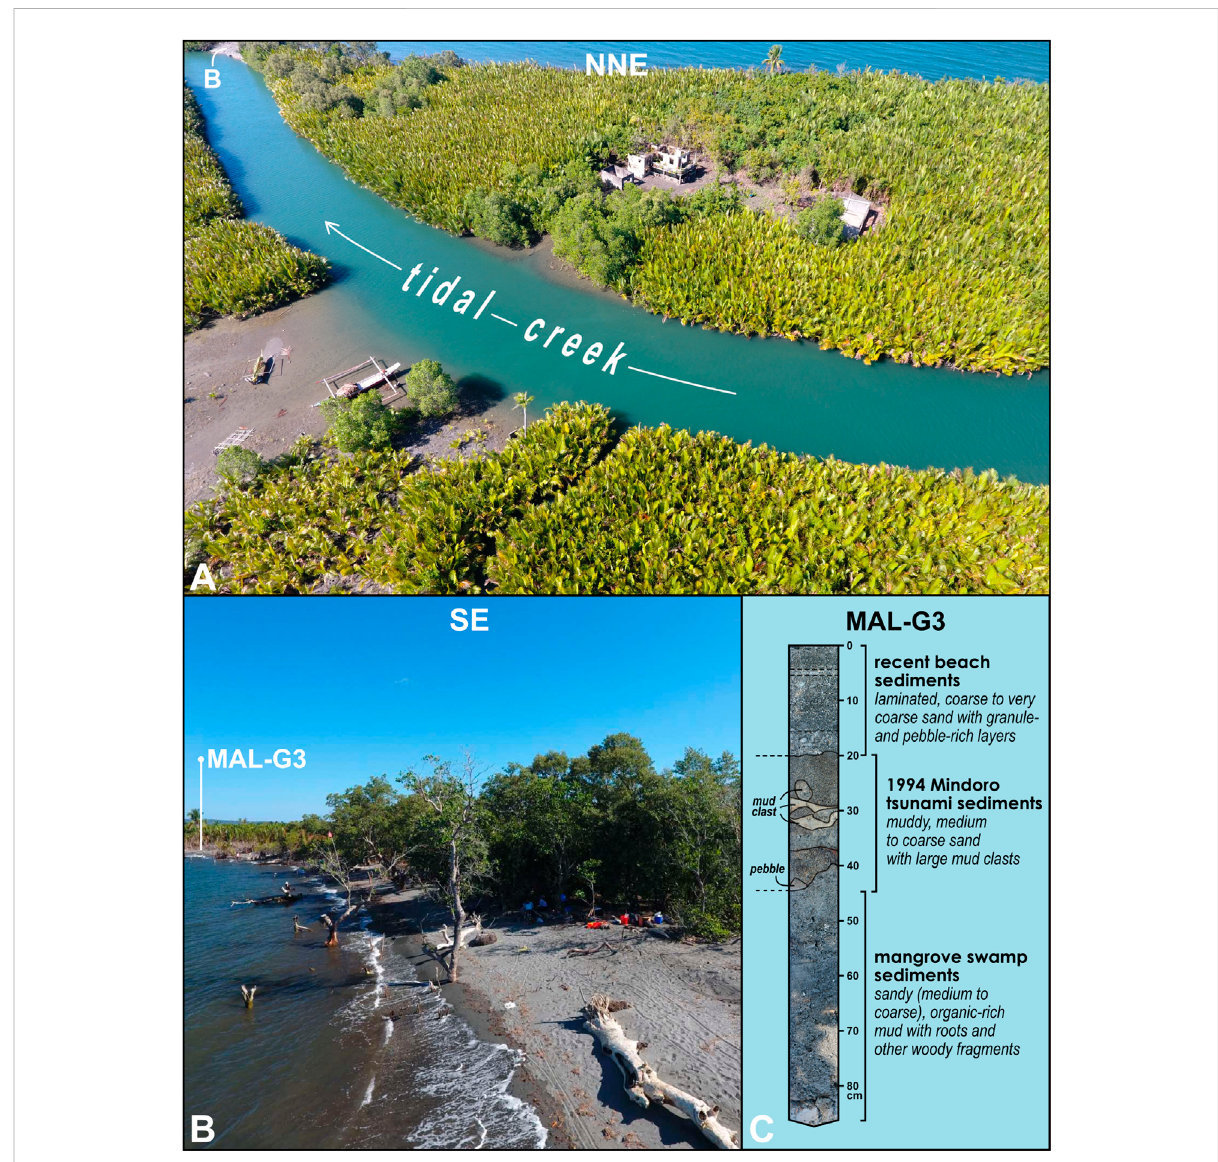
FIGURE 2 Barangay San Andres in Oriental Mindoro, 25 years after the 1994 tsunami. (A) NNE-looking image overlooking Sitio Malaylay in Barangay San Andres, taken during low tide. The area is mostly a mangrove swamp, with Nypa fruticans as the most common mangrove. Note the dilapidated structureswhichwereinitiallydamagedbythe1994tsunami.ThelocationofFigure2AisshowninFigure1C.Theexposedtidalbarintheforeground of B is also labeled. (B) SE-looking, along-the-coast view of Sitio Malaylay. Note the protruding trunks of drowned mangrove trees along the foreshore and the absence of the tsunami beach ridge that was deposited by the 1994 tsunami, both of which indicate post-1994 coastal erosion. The location of a geoslicer sample, MAL-G3, is also shown. (C) Visual stratigraphic interpretation of MAL-G3. The 1994 Mindoro tsunami deposit is partially preserved, overlying the older mangrove swamp